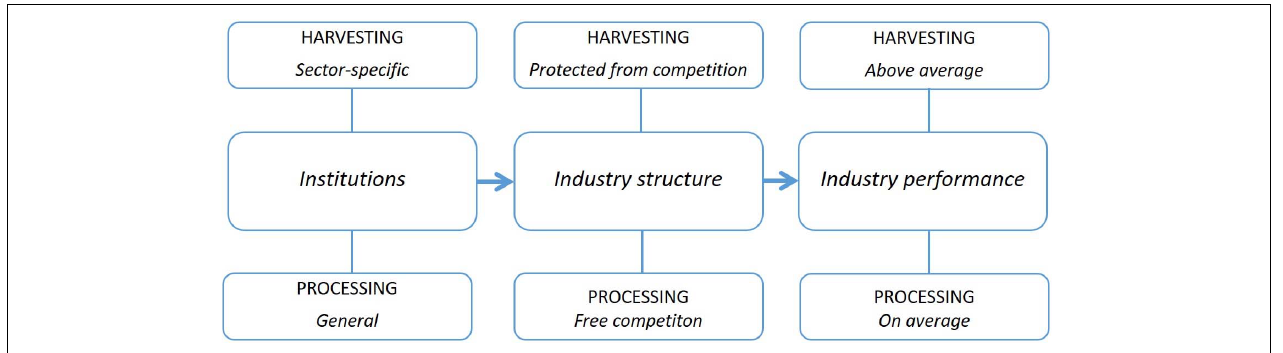
FIGURE 1 | Analytical model and expected empirical